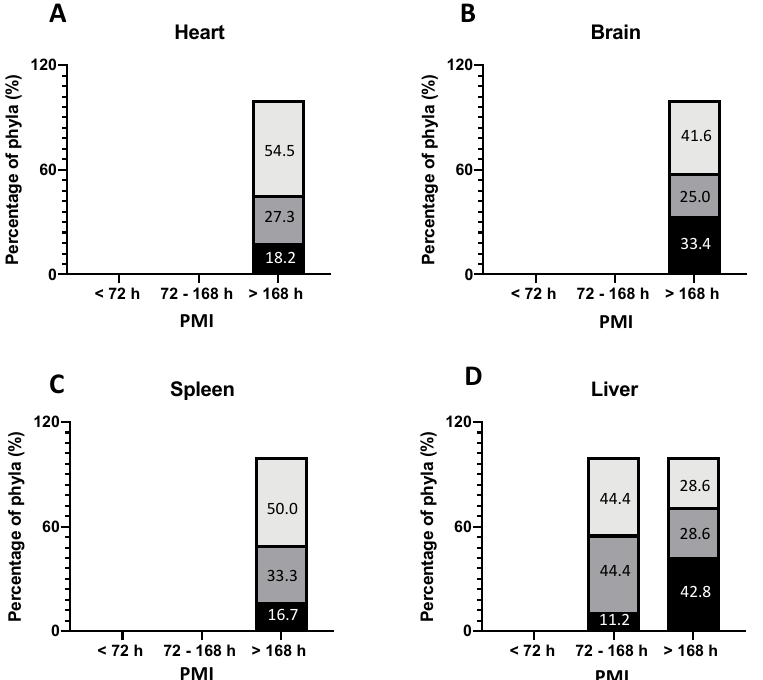
Figure 4 : The frequency of phyla among the four internal anatomical sites according to PMI. ( A ) heart; ( B ) brain; ( C ) spleen and ( D ) liver. [ Firmicutes, Proteobacteria, Ascomycota, Actinobacteria].